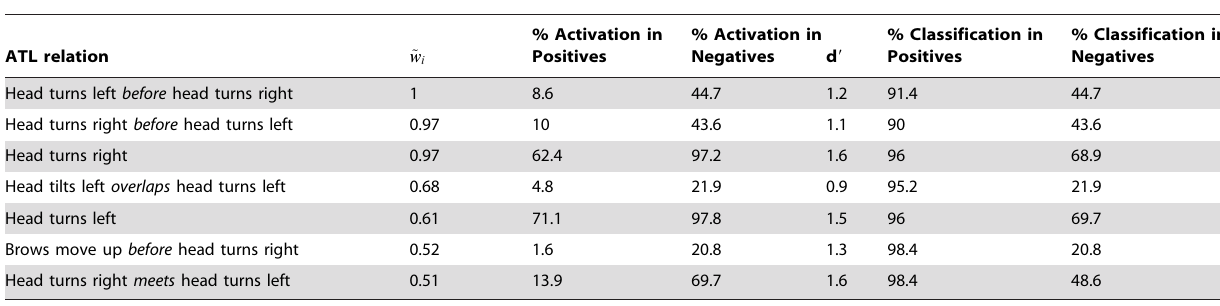
Table 11. Discriminant features for polarity in Assertions.